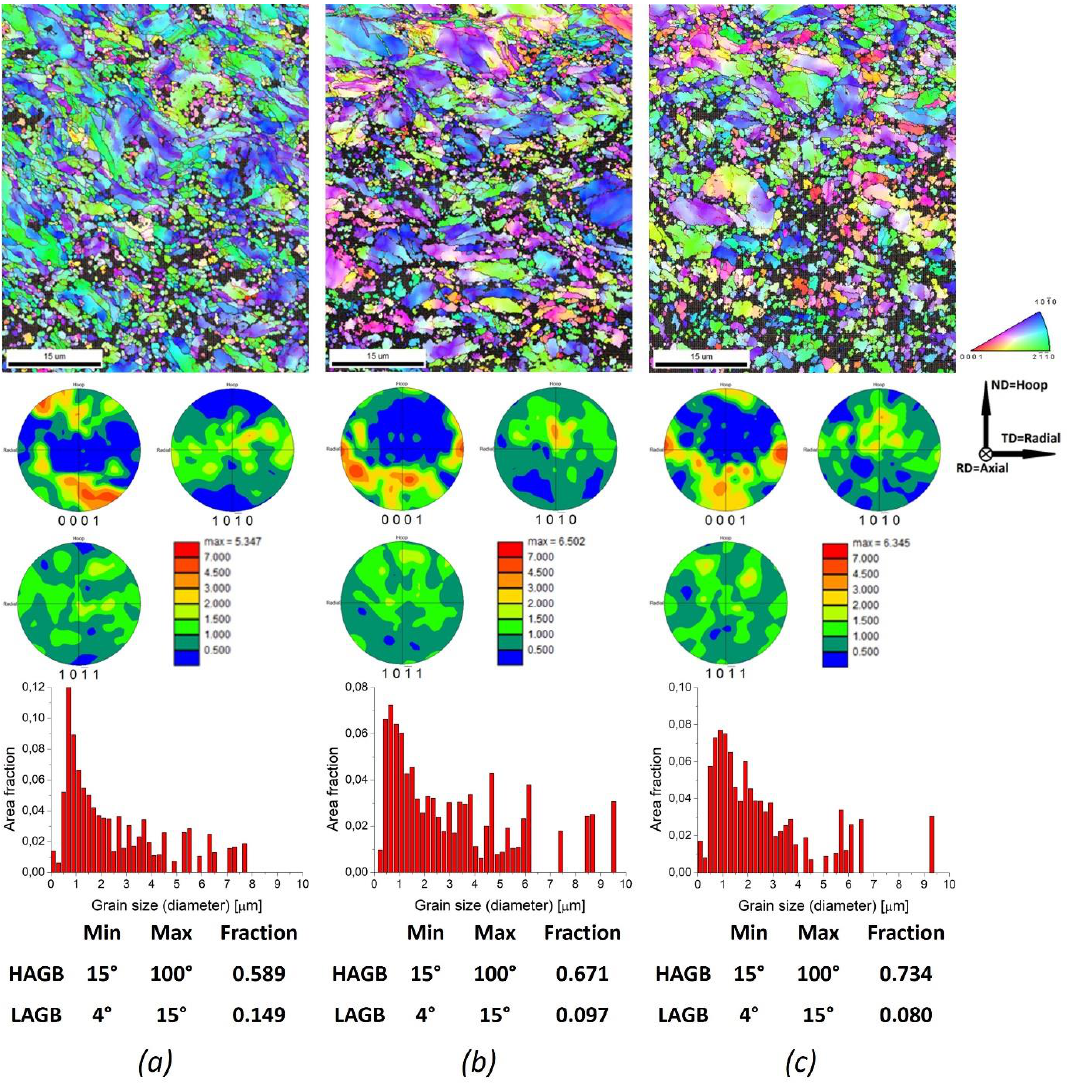
Figure 5. Grain orientation maps, local micro-textures, grain size distributions, and the HAGB and LAGB fractions of the sample after the first C-ECAP pass in the periphery ( a , c ) and in the center of the sample ( b ).